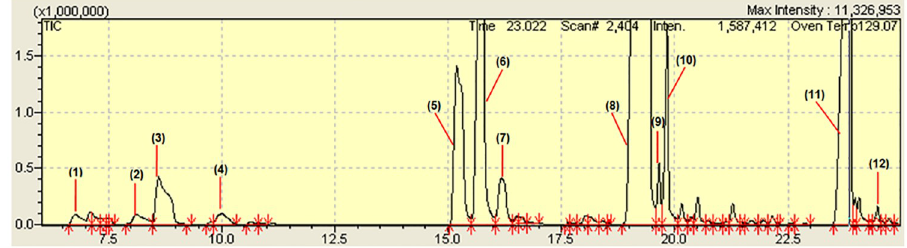
Fig 1. Obtaining gas chromatography of OE O . majorana L. gas trap: Helium (He); initial temperature 60 ˚C; initial time 1.0 min; the column temperature increased 3 ˚C/ min. at 240 ˚C, maintained at this temperature for 30